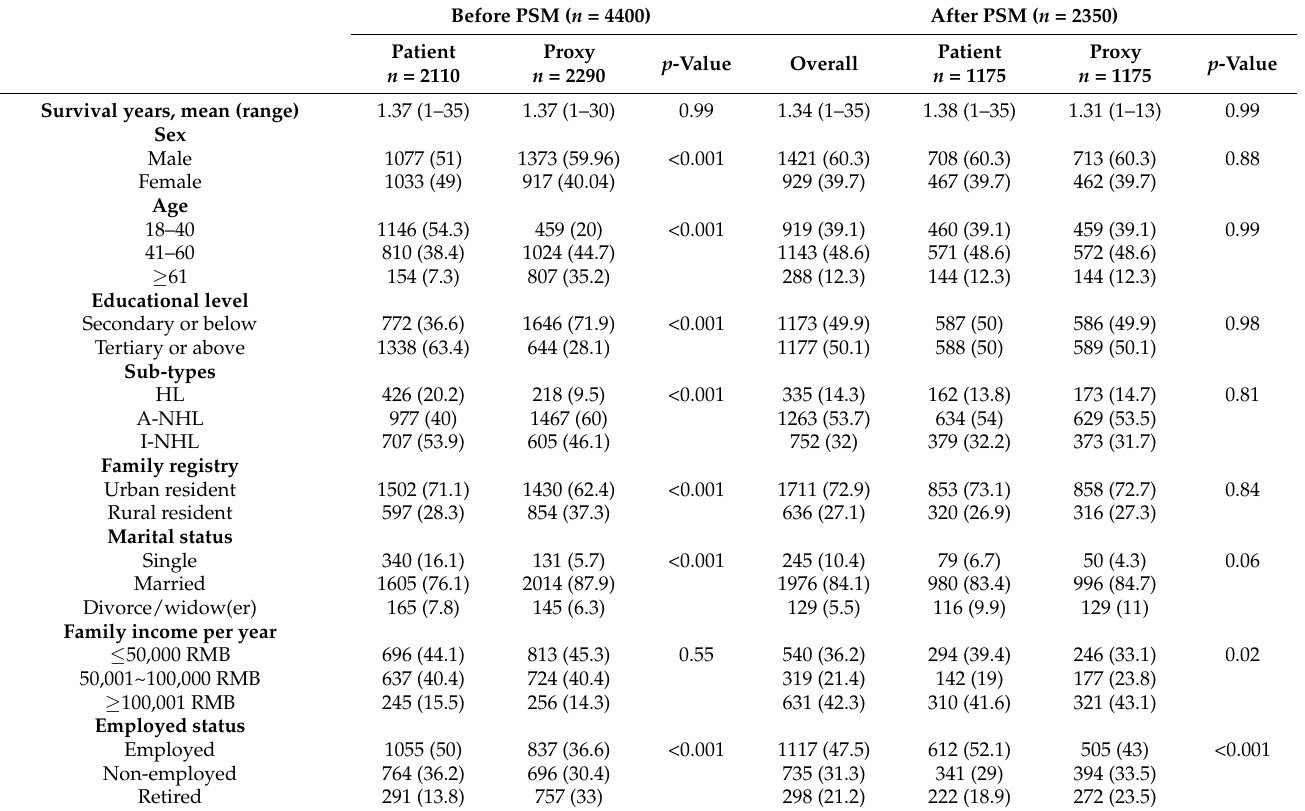
Table 1. Respondent’s